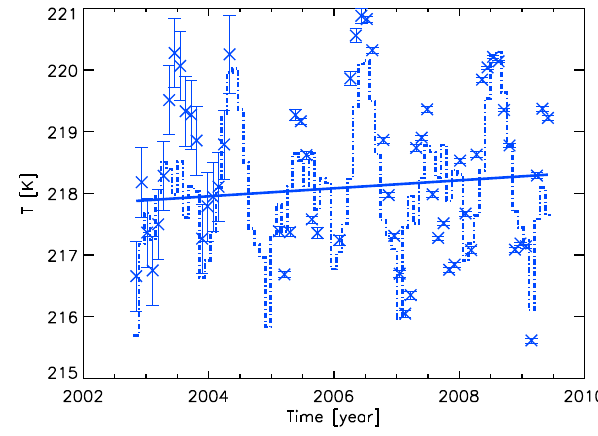
Fig. 2. Linear trends from MIPAS 32-day mean temperatures at 25km altitude, 30 ◦ S–30 ◦ N, with consideration of sine and cosine corrections for the quasi-biennial oscillation and the semi-annual oscillation. Test cases represent different treatment of the bias, for details see Fig. 1. The linear term of the regression function is shown for all cases 2.1–2.6, while, for reasons of clarity, the full regression curve is shown for case 2.1 only. Representative error bars include both the random error and – if considered in the re- spective case – the bias.